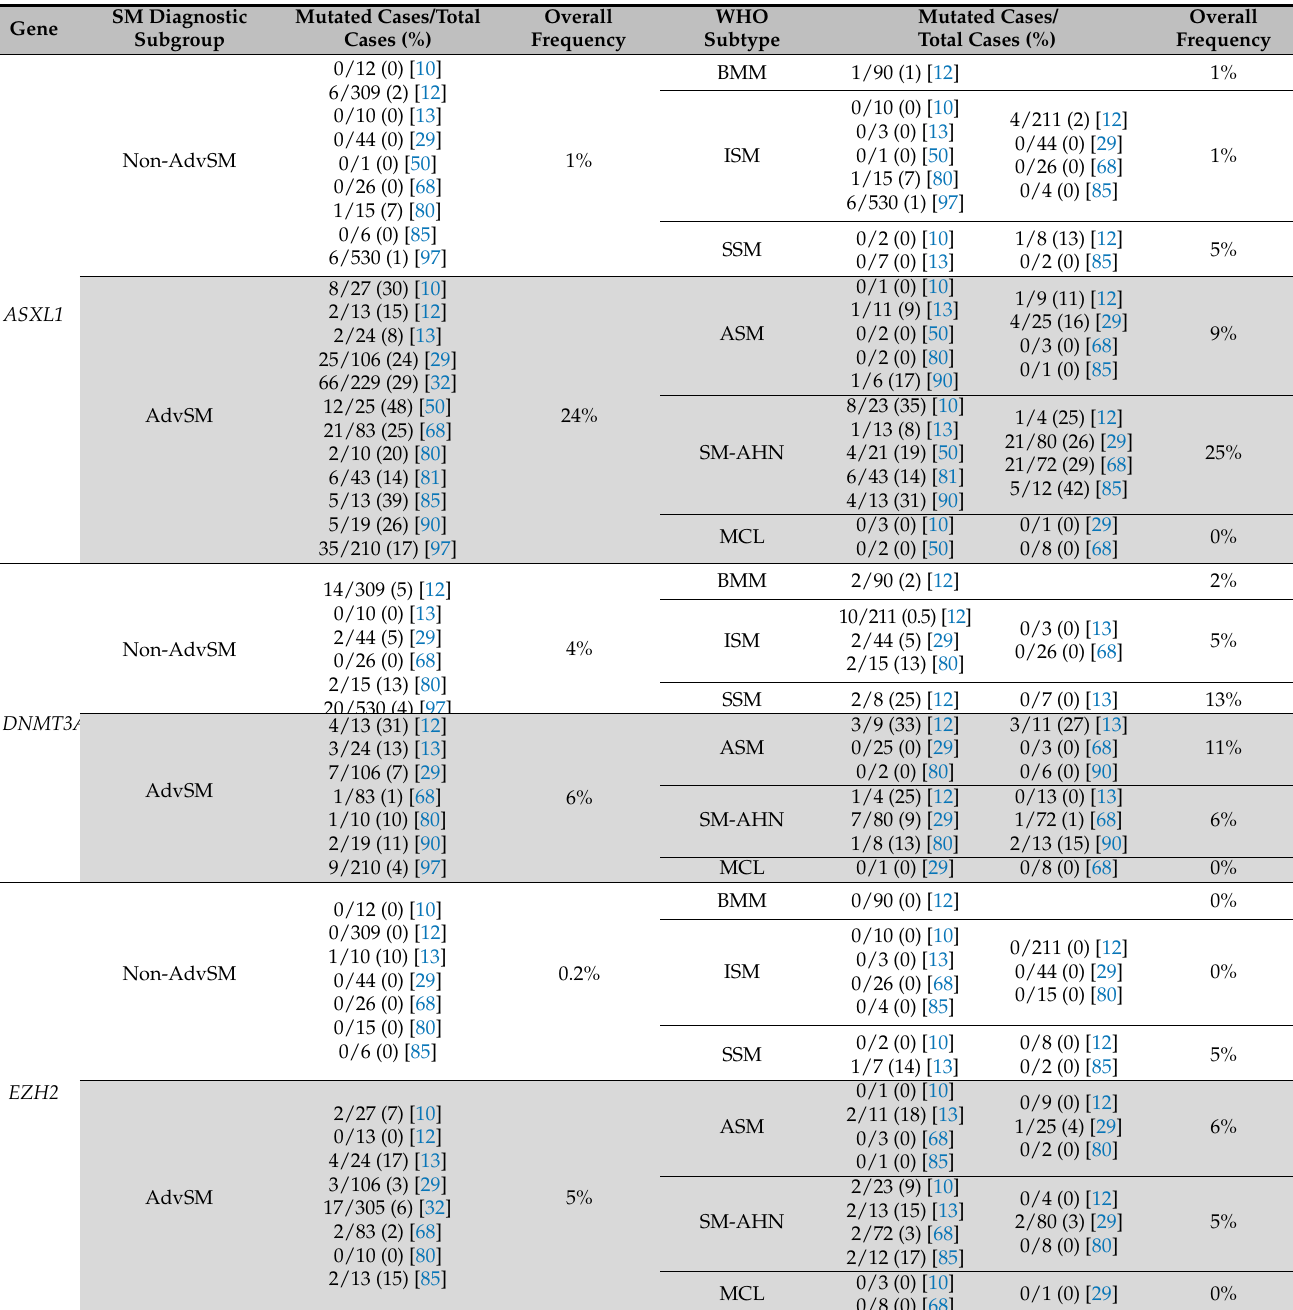
Table 4. Frequency of mutations in genes involved in epigenetic regulatory mechanisms found to be recurrently altered in systemic